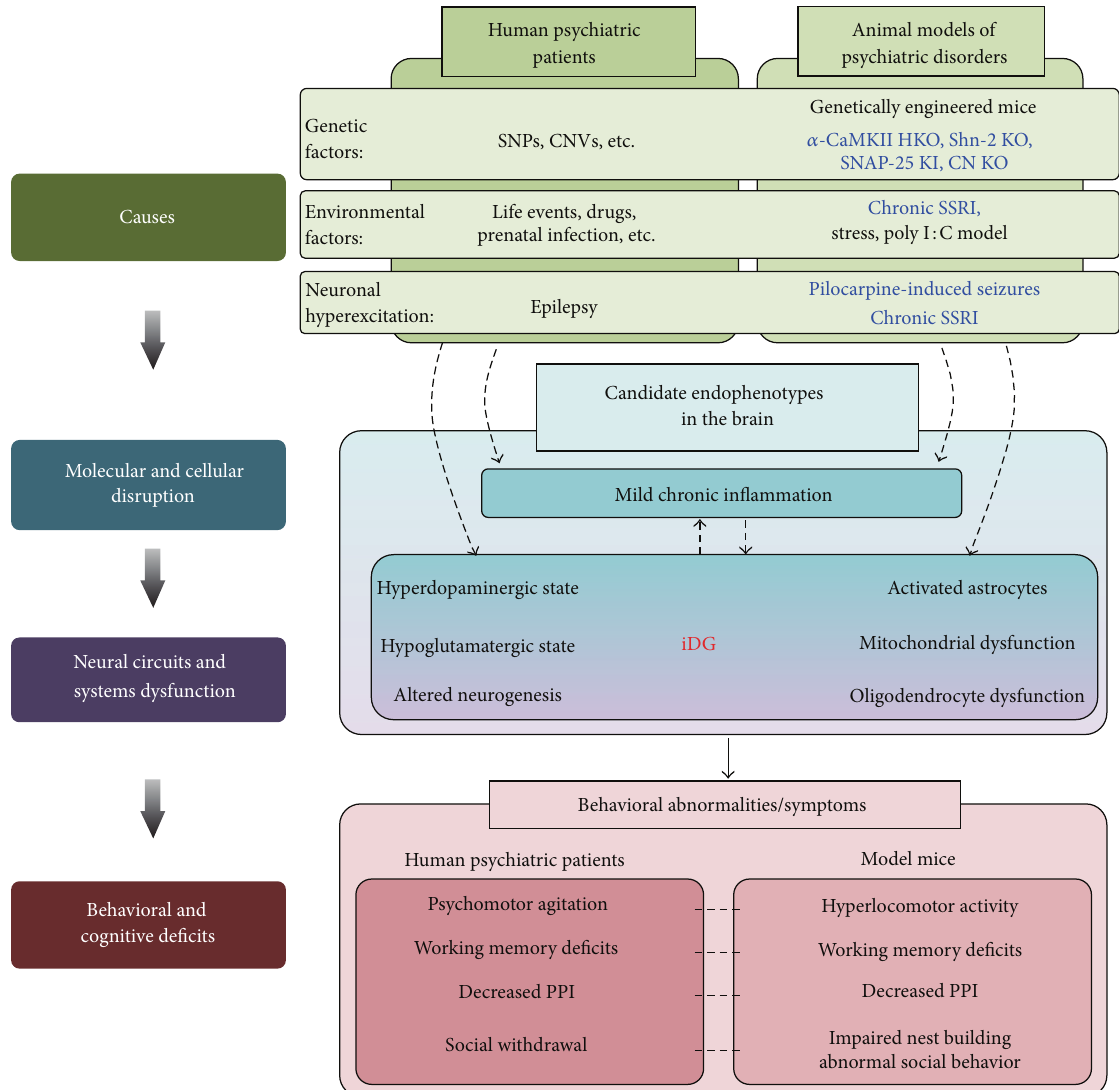
Figure 7: A schematic representation of the model of involvement of the iDG phenotype in psychiatric disorders. In psychiatric disorders, such as schizophrenia, bipolar disorder, and depression, multiple genetic and environmental factors could induce mild chronic inflammation. This could subsequently result in multiple endophenotypes in the brain, including iDG. Inflammation could induce alterations in neurogenesis [106, 107], mitochondrial dysfunction [108, 109], and oligodendrocyte dysfunction [110, 111]. Involvement of inflammation in induction of a hypoglutamatergic state or hyperdopaminergic state remains unclear. These possible endophenotypes may affect each other, which may, in turn, cause behavioral abnormalities in psychiatric patients. There may not be a single “principal” or “core” mechanism that underlies the behavioral symptom of psychiatric disorders. Indeed, a shared or preserved set of multiple endophenotypes, as a whole, may be the principal mechanisms of these